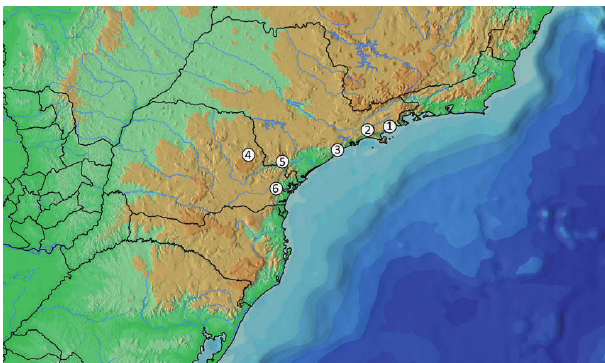
Fig. 1. Partial map of South America showing the Characidium species collection sites. 1 = Ubatuba, SP ( Characidium lauroi ), 2 = Salesópolis, SP ( Characidium oiticicai and Characidium cf. zebra ), 3 = Itanhaém, SP ( Characidium sp.), 4 = Jaguariaíva, PR ( Characidium schubarti ), 5 = Apiaí, SP ( Characidium pterostictum ), 6 = Morretes, PR ( Characidium lanei